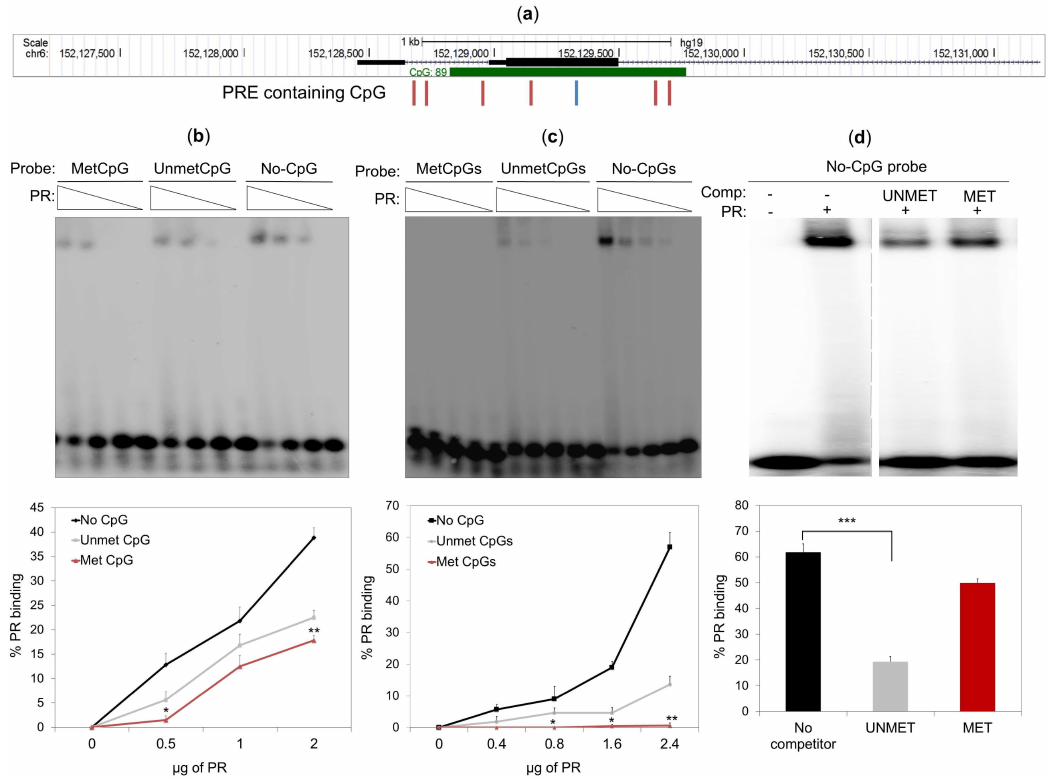
Figure 6. DNA methylation impedes PR binding to progesterone-responsive elements (PREs). ( a ) Screen shot from the UCSC genome browser showing the CpG island (CpG 89) at the ESR1 promoter and the positions of the canonical PREs containing a CpG (blue line) and six half-palindromic PREs with one or two neighboring CpGs (red lines). ( b , c ) Electrophoretic-mobility shift assay using the indicated amount of purified human PR to capture the PRE with no CpG (ACAGTTTGT; no CpG), one methylated (MetCpG) or unmethylated CpG (UnmetCpG) (ACGGTTTGT) ( b ); two methylated (MetCpGs) or two unmethylated CpGs (UnmetCpGs) (ACGGTTCGT) ( c ). Quantification of the percentage of PR binding to different probes is shown in the lower part of the gel images. Error bars represent the SD of three independent experiments. * p less than or equal to 0.05, ** p less than or equal to 0.01, unpaired two-tailed Student’s t -test. ( d ) A double-stranded oligonucleotide probe with no CpG (ACAGTTTGT) was incubated with 2.4 µ g of purified human PR and analyzed by PAGE either in the absence (–) or presence (+) of 100-fold excess of unlabeled oligonucleotides containing two unmethylated (UNMET) or two methylated (MET) CpGs (ACGGTTCGT). Error bars represent the SD of three independent experiments. *** p less than or equal to 0.005, unpaired two-tailed Student’s t -test. The dashed grey line indicates that a lane between the two samples was